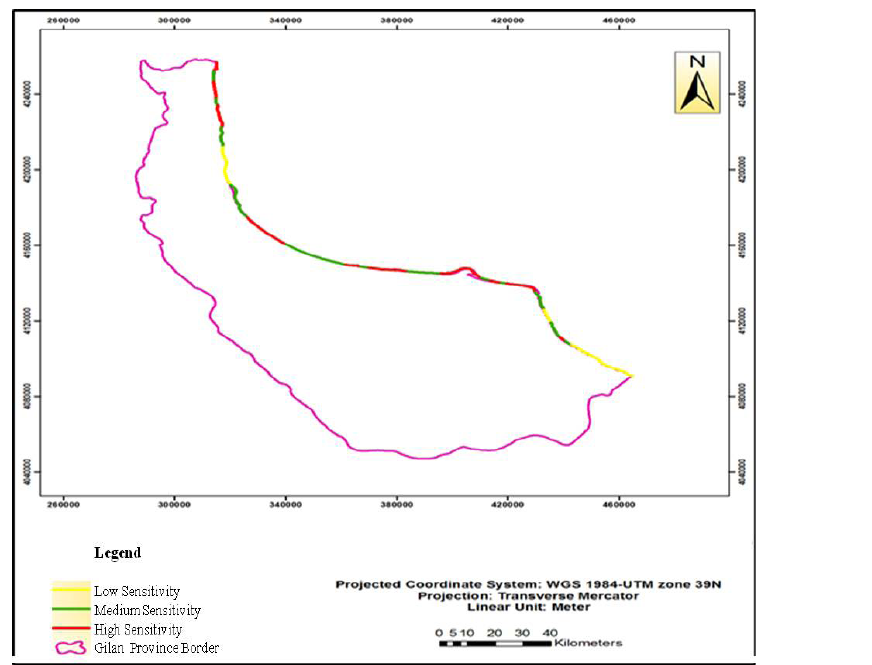
Figure 4. Final map of the coastal strip environmental sensitivity to oil spills